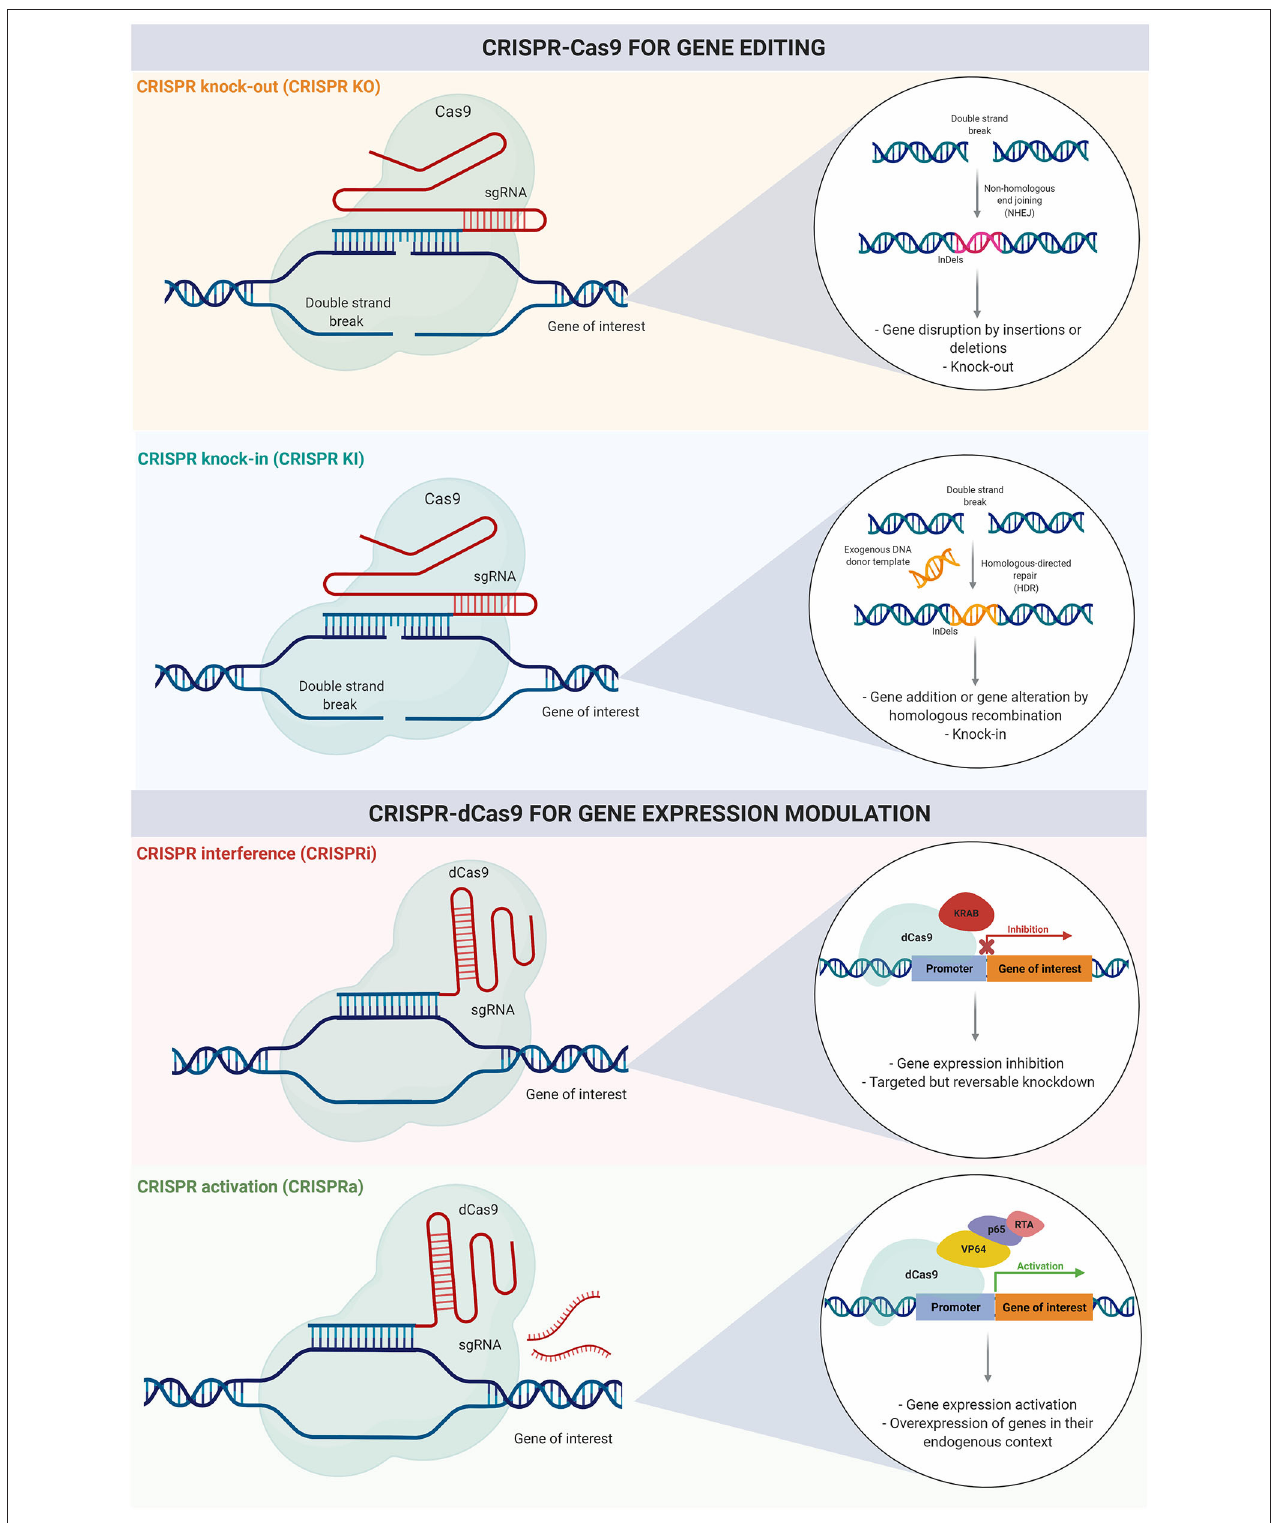
FIGURE 3 | CRISPR-Cas9 for gene editing and gene expression modulation. Genome engineering using CRISPR-Cas9 can be used for gene editing with insertions or deletions resulting in gene knock-out, or for knock-in using homologous recombination. Recently, CRISPR has evolved toward gene expression modulation; CRISPR intereference (CRISPRi) and CRISPR activation (CRISPRa) can be used for transient inhibition or activation of gene expression respectively.